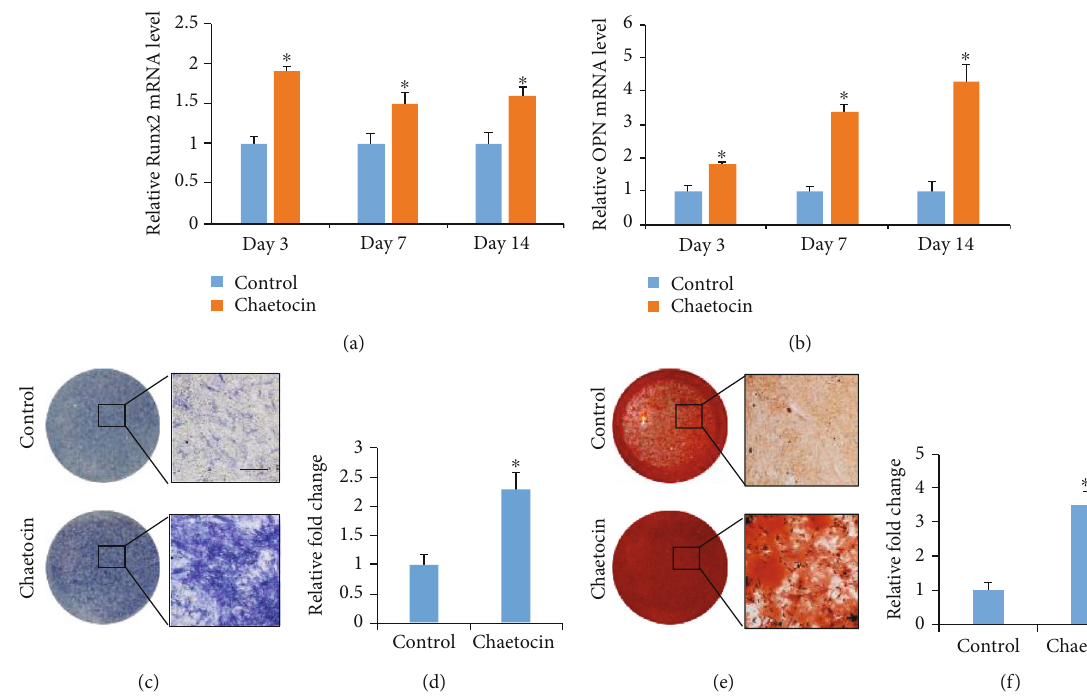
Figure 1: E ff ect of Chaetocin on MSC osteogenic di ff erentiation. (a, b) Real-time RT-PCR analysis shows that expression of both early and later osteogenic markers (Runx2, OPN) was signi fi cantly enhanced by treatment with Chaetocin. (c, d) ALP staining showed a signi fi cant increase of ALP activity in MSCs treated with Chaetocin. (e, f) ARS staining showed a signi fi cant increase of calcium deposition in MSCs treated with Chaetocin. PCR and quanti fi cation data are expressed as means ± s : d : of three independent experiments ( ∗ p < 0 : 05 ). Scale bar: 100 μ m. 00.30.60.91.21.5